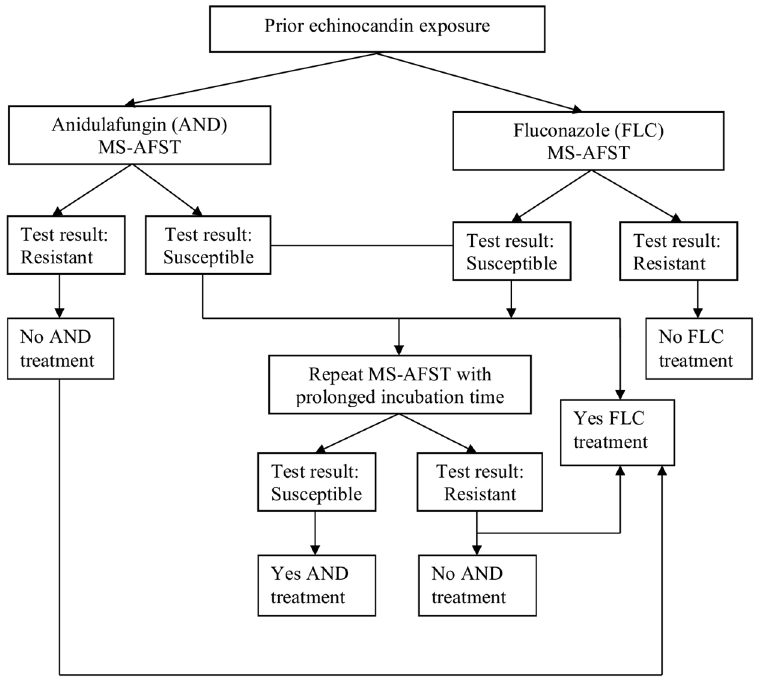
Figure 3. Flow chart diagram illustrating the potential use of the dual MS-AFST in clinical practice. A scenario of prior echinocandin exposure is shown, where MS-AFST results for a C. glabrata clinical isolate as susceptible or resistant to anidulafungin (AND) and/or fluconazole (FLC) may be useful to drive the appropriate administration of antifungal therapy. For AND, valid MS-AFST results can be available after 3 h or, in cases of isolates with FKS2 HS1 mutations, 6–12 h of antifungal exposure in vitro